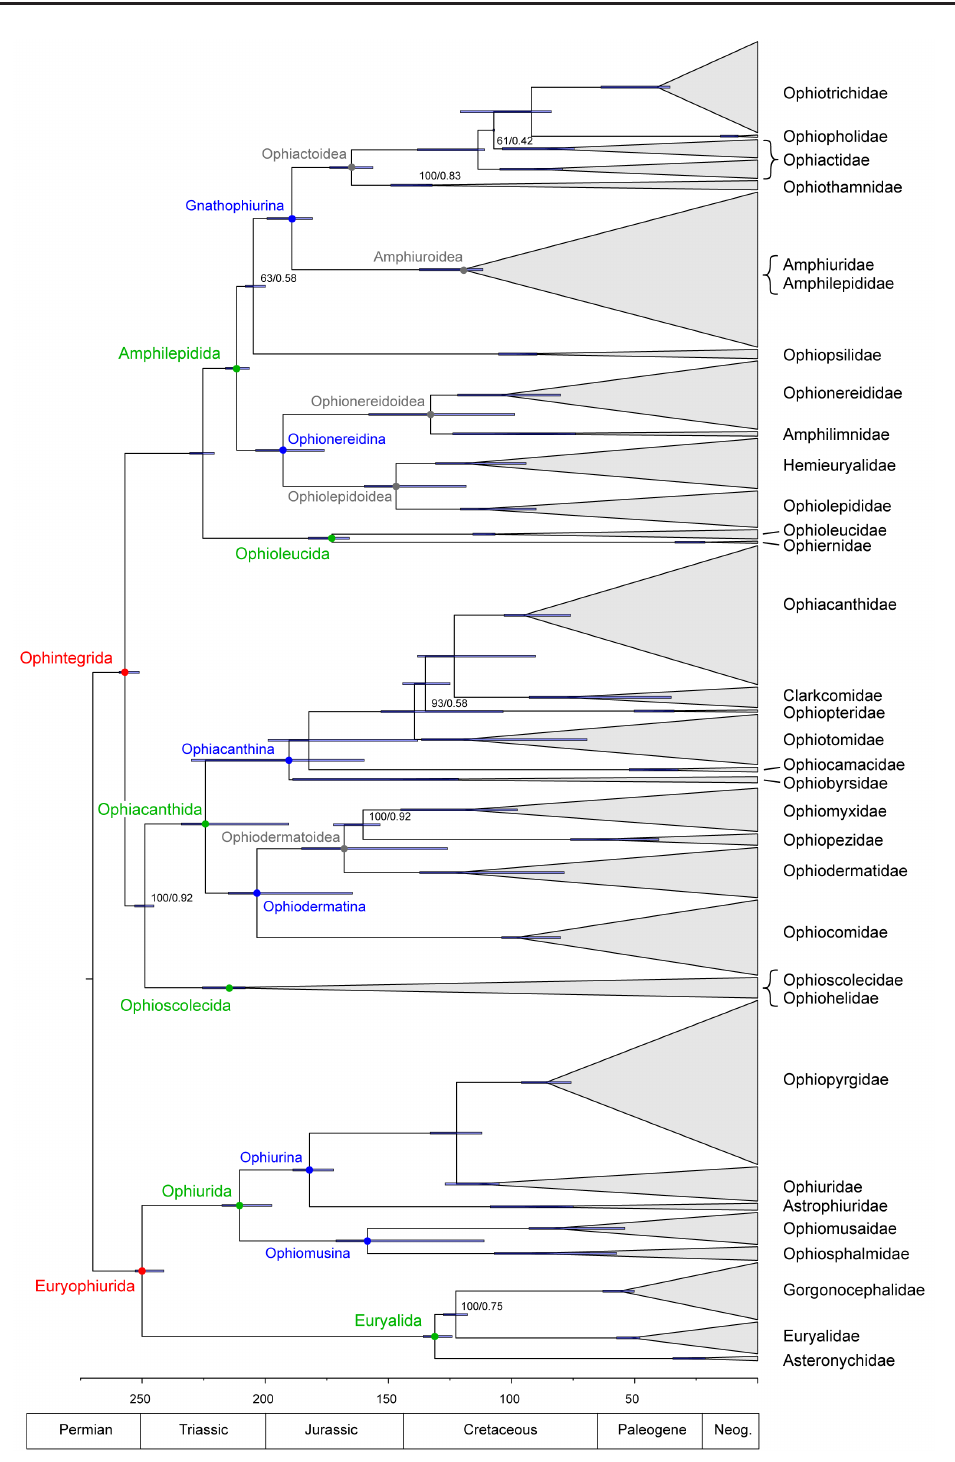
Fig. 1. Summary phylogenetic tree of the ophiuroid higher taxonomy. Modified from O’Hara et al . (2017: fig. 1), with Ophiobyrsidae included based on O’Hara et al . (2017: fig. S3) sample Ophiuroidea_ sp_IE.2009.1713 (= Ophiophrixus _ confinis ) and additional unpublished exon-capture data on samples Ophiobyrsa _ rudis _F222711 and Ophiosmilax _sp_IE.2207.6967. All-sites PLRS/RAxML tree with node support and age confidence intervals (coloured bars). Node support shows all-sites RAxML BS followed by the proportion of the data subset trees in agreement. For all other nodes support was 100/1. The root was fixed according to O’Hara et al . (2014) at 270